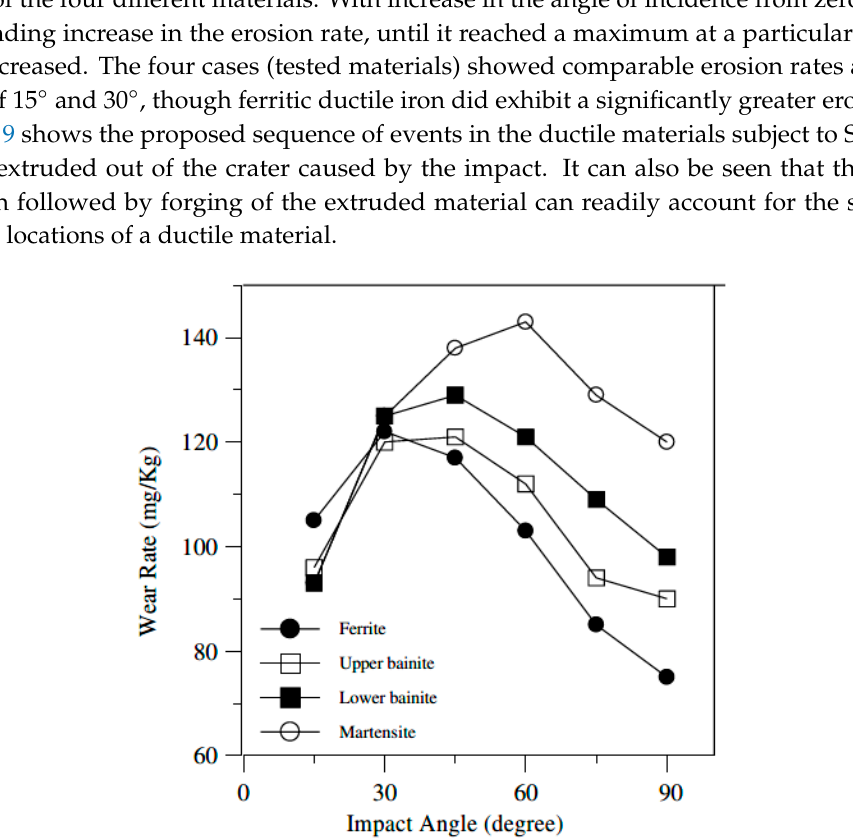
Figure 8. Effect of impact angle on wear rate for four different iron matrices. Reproduced with permission from [55]. Elsevier, 2005.